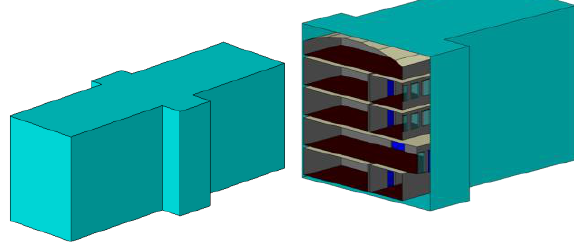
Figure 5: Building with detailed interior structure and an extrusion as exterior shell (source KIT)